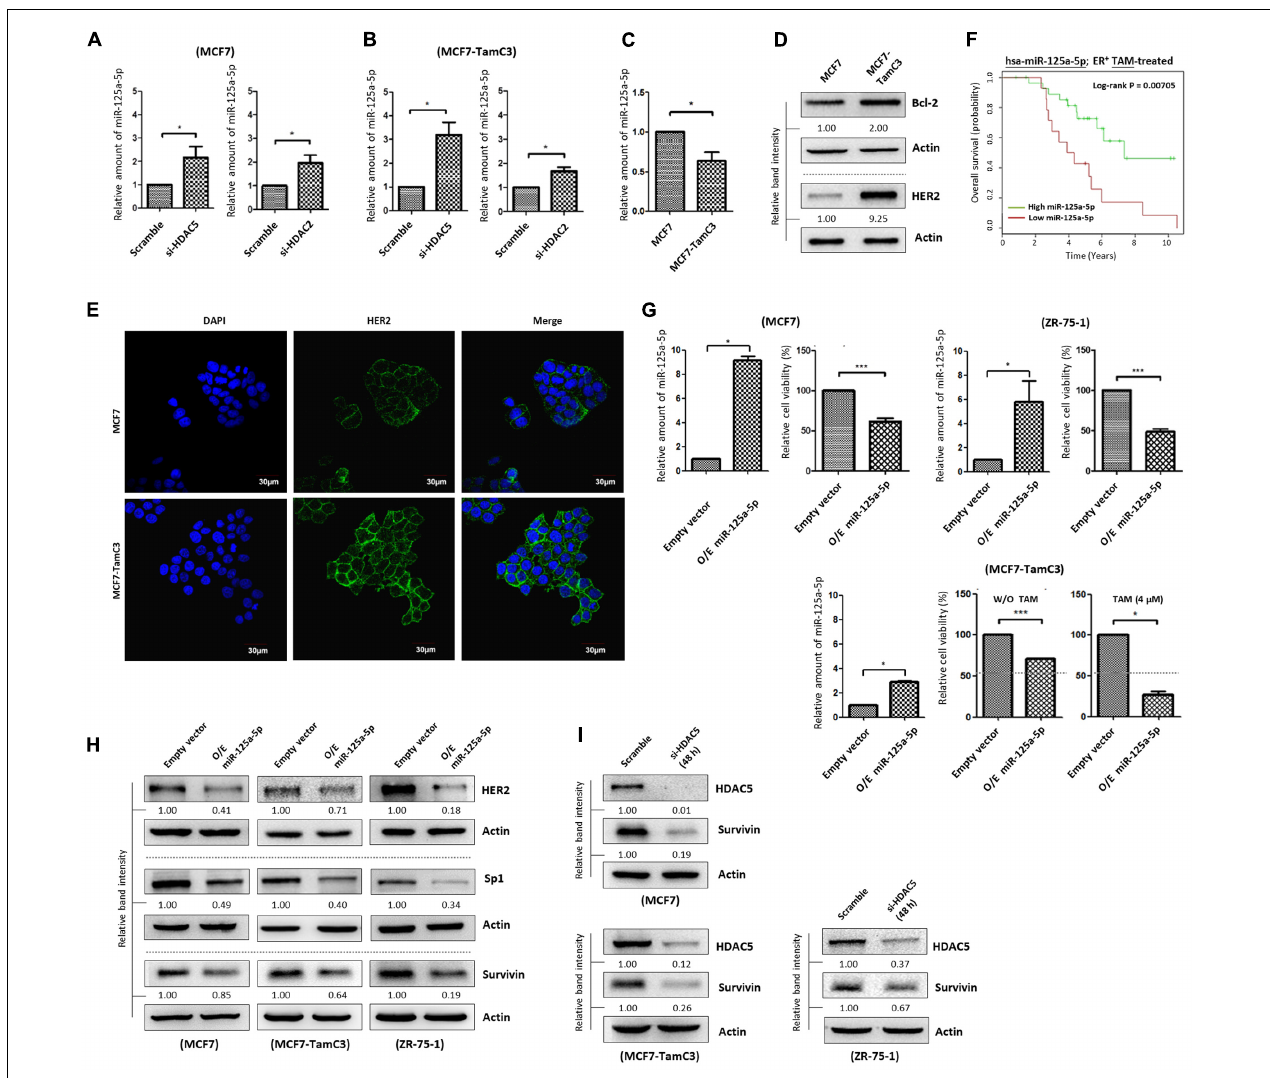
FIGURE 6 | HDAC2 and HDAC5 negatively regulate the expression of miR-125a-5p in ER + breast cancer cells. (A,B) Breast cancer cells were transfected with scramble siRNA, HDAC2 siRNA, or HDAC5 siRNA for 48 h and expression of miR-125a-5p was determined by qPCR. “ ∗ ” denotes a statistical significance ( P < 0.05) between the testing groups. (C) Expression of miR-125a-5p in MCF7 and MCF7-TamC3 cells was determined by qPCR. (D) The expression of Bcl-2 and HER2 in MCF7 and MCF7-TamC3 cells were determined by Western blotting. (E) The cell surface expression HER2 (green) in MCF7 and MCF7-TamC3 cells was assessed by immunofluorescence confocal microscopy. Nuclei were countered stained by DAPI (blue). (F) Kaplan–Meier survival estimates of high (green line) or low (red line) miR-125a-5p expression in ER + tamoxifen-treated breast cancer. (G) MCF7 and ZR-75-1 cells were transfected with either pLV-[mir-control] (empty) or pLV-[has-mir-125a-5p] (O/E miR-125a-5p) for 96 h. MCF7-TamC3 cells were pre-transfected with either pLV-[mir-control] or pLV-[has-mir-125a-5p] for 24 h and subsequently treated with or without tamoxifen for 72 h. Cell viability was determined by the MTT assay. “ ∗ ” and ∗∗∗ ” denote a statistical significance ( P < 0.05 and P < 0.001, respectively) between the testing groups. (H) Breast cancer cells were transfected with either pLV-[mir-control] or pLV-[has-mir-125a-5p] for 48 h and expression of, HER2, Sp1, and survivin was determined by Western blotting. Actin was used as an internal control. (I) MCF7, MCF7-TamC3, and ZR-75-1 cells were transfected with either scramble or HDAC5 siRNA for 48 h and expression of survivin was determined by Western